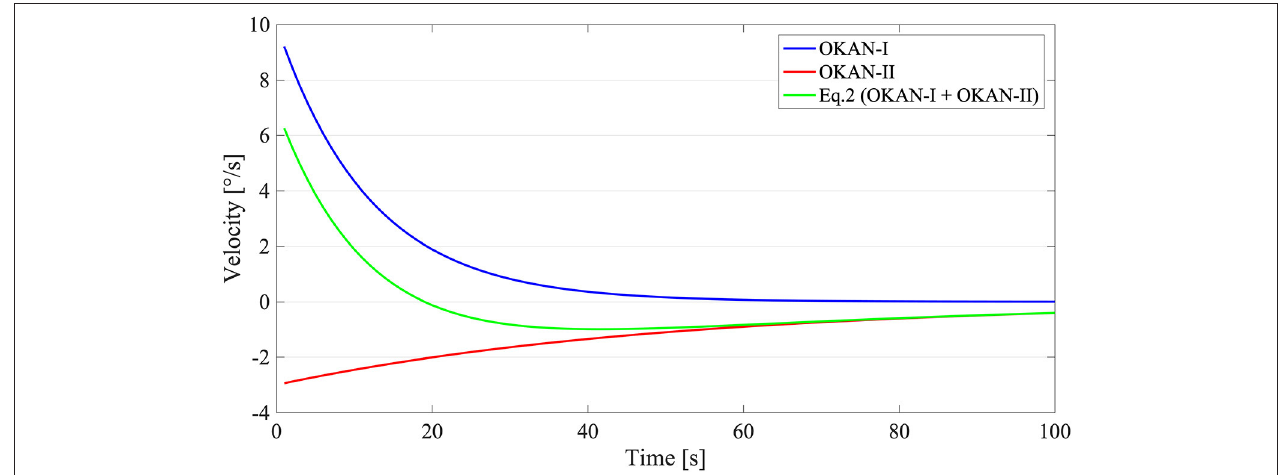
FIGURE 1 | Graphical Explanation of Equation (2). The blue line stands for OKAN-I ( a · e − t /τ 1 ) with an initial velocity of 10 deg/s and a time constant of 12s. The red line on contrary symbolizes OKAN-II ( − b · e − t /τ 2 ) with an initial velocity of 3 deg/s and a time constant of 50s. The green line corresponds with Equation